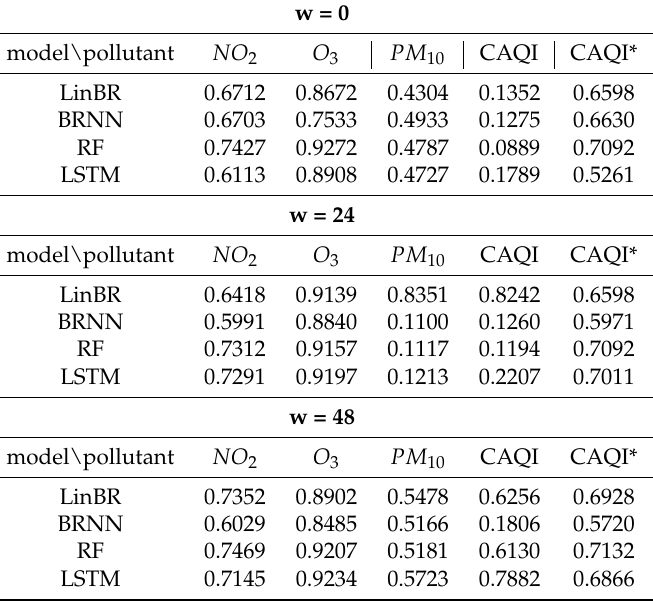
Table 9. F1-scores obtained on the sub-indices of each pollutant, on the global indices CAQI and CAQI* (without PM 10 ), using the same configurations with time windows equal to zero, one and two